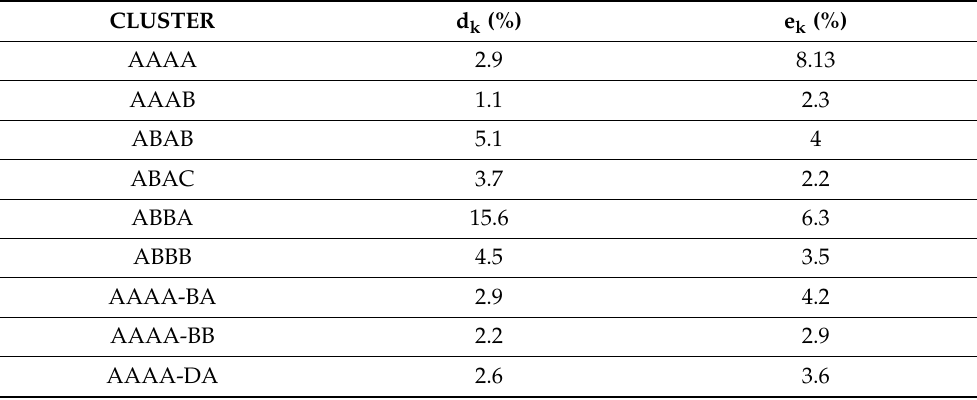
Table 4. The deviation, d ( (cid:100) Y k , m ) , and the error, e k ( (cid:100) Y k , m ) , of full profiles (cid:100) Y k , m